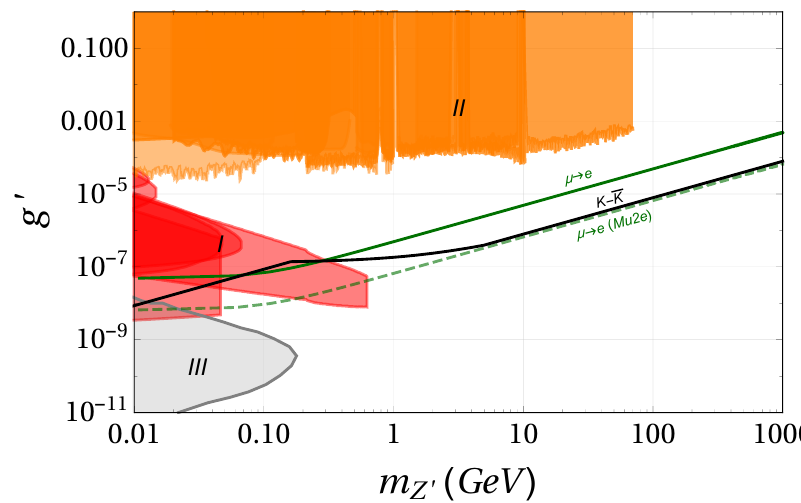
Figure 13 . The strongest bounds on the Z 0 mass as a function of gauge coupling g 0 of the horizontal G FN = U(1) FN group, setting kinetic mixing to zero. Region I (II) collects bounds due to the direct production of Z 0 in proton and electron beam dumps (at e + e (cid:0) colliders), while Region III shows the exclusion from SN1987A. The solid (dashed) dark green line depicts the present (future) (cid:22) e ! (cid:22) K mixing, see text for bound, the solid black line the bound from K (cid:0)